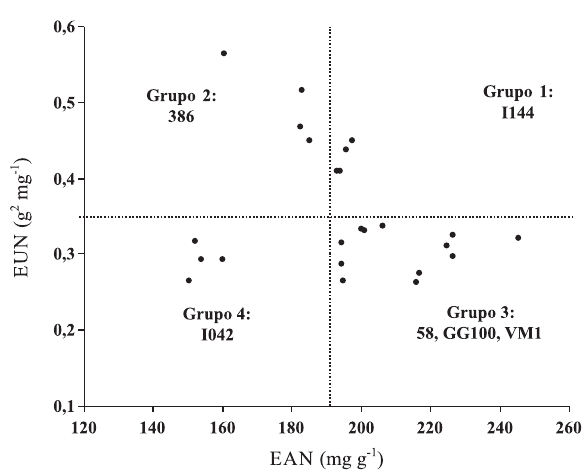
Figura 2. Diagrama de distribuição dos clones de eucalipto em função das eficiências de absorção (EA) e de utilização (EU) de nitrogênio.